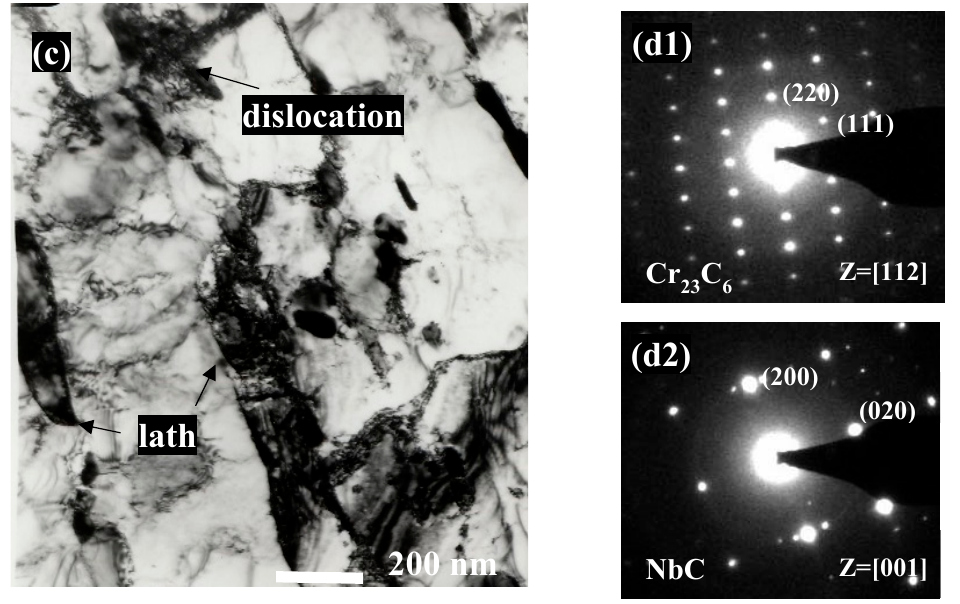
Figure 2. Transmission electron micrographs at each fatigue damage fraction of 600 s hold time showing dislocation substructures and precipitates; ( a ) as-tempered, ( b ) 0.2 N f , ( c ) 1 N f , ( d1 ) selective area diffraction (SAD0 patterns of Cr 23 C 6 and ( d2 ) SAD patterns of NbC.